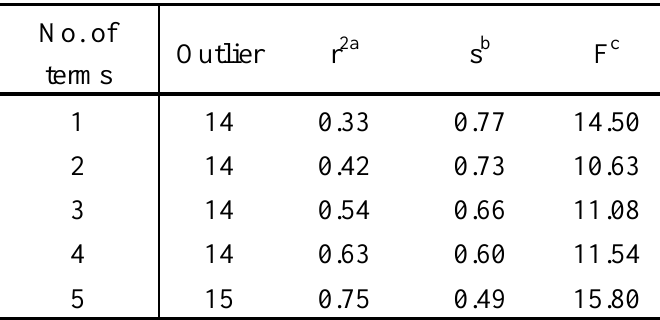
Table 2. Elimination of the outlier from the best QSAR equation and the corresponding statistical values in relation to the number of